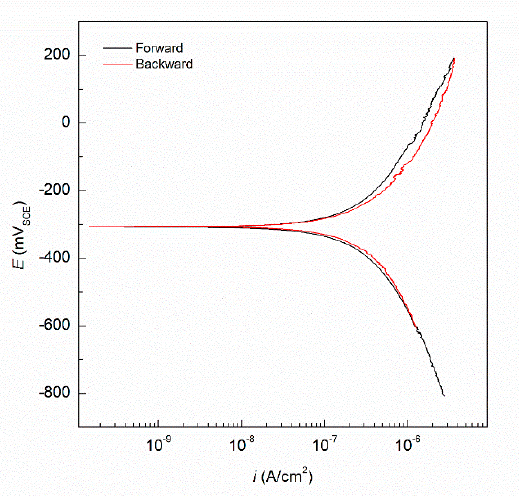
Figure 3. DL − EPR plot for Inconel 718 annealed at 1000 °C for 10 min and water quenched, reapeated three times each, sample I2.